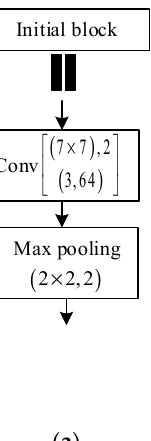
m 1 Figure 8. The construction of D-Block. 3. Experiments The research experiments are performed on the processing dataset and the public Massachusetts Road Dataset [39], respectively. The deep learning framework selects Ten- sorFlow as the platform to train and test the relative networks. In addition, two sets of NVIDIA GTX 2080 Ti GPU are bridged to guarantee computing power. 3.1. Datasets The method is evaluated with the processing team dataset from the WorldView-4 satellite, including 6736 training images with a spatial resolution of 0.31 m and 1012 sim- ilar test images. After data augmentation including color jittering, horizontal flip and